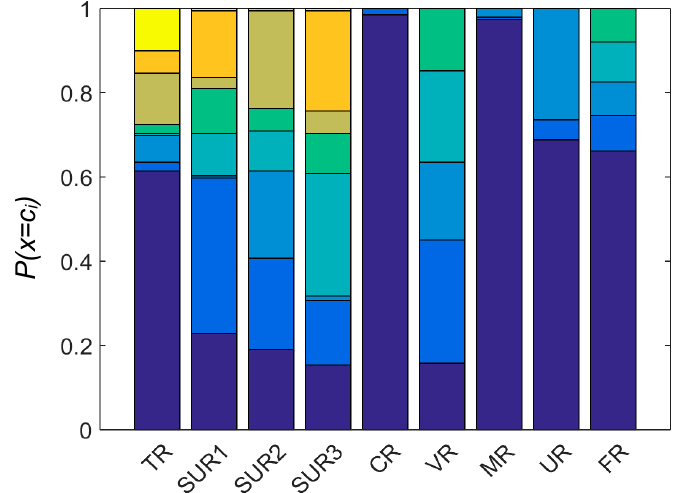
Figure 7. The probability distribution P ( x = c i ) of categorical variables. Each bar represents a single variable, the number of colors represents the unique value c i of a given feature, and the height of each color bar represents the frequency of value c i . For details see the description presented in Table 1.